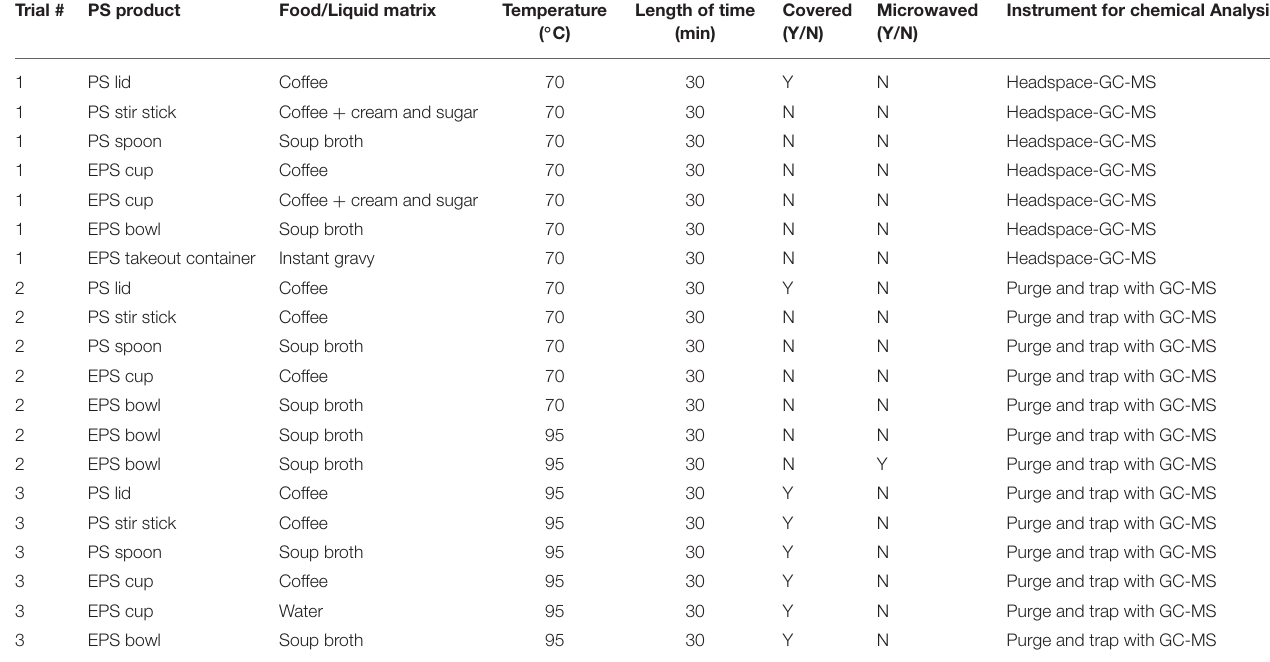
TABLE 1 | Detailed information about all treatments in leaching